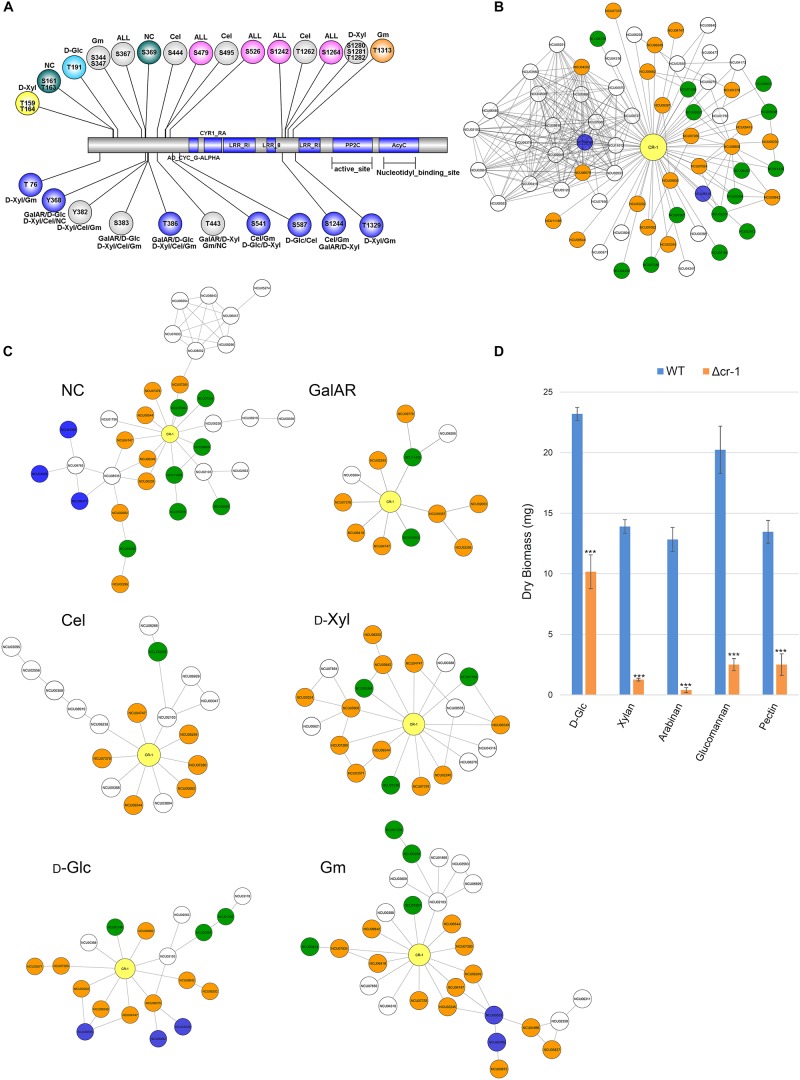
Carbon source-dependent changes of CR-1 interactions. (A) Phospho-site distribution of CR-1 in response to substrate conditions. Picture shows all possible sites of phosphorylation. GalAR (D-GalA + L-Rha), D-Glc (D-Glucose), D-Xyl (D-Xylose), Cel (cellobiose), Gm (Glucomannodextrins), NC (No carbon). Colored circles represent sites with Ascore > 13, and gray circles with AScore < 13. (B) Set of proteins directly interacting with CR-1. Colors according to functional categories: green, signal transduction; orange, kinases; blue, metabolism. (C) Sub-PPI-networks of CR-1 nodes represent proteins that interact with CR-1, those peptides were found specific phosphorylated at condition. Colors according to functional categories described in panel (B). (D) Mycelial biomass (dry weight) of the Δcr-1 mutant relative to on D-Glc, xylan, arabinan, glucomannan and pectin. Error bars represent the standard deviation from triplicate experiments. Statistical differences were calculated using t-test (∗∗∗p < 10E-5).